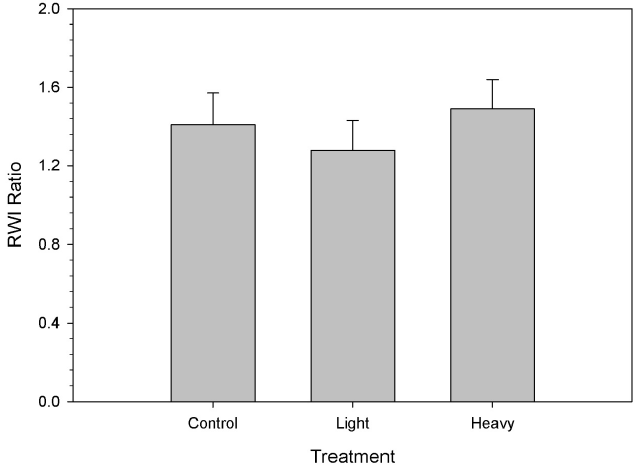
Figure 4. Average (±SE) Pinus resinosa ring width index ratio for trees in control and thinning